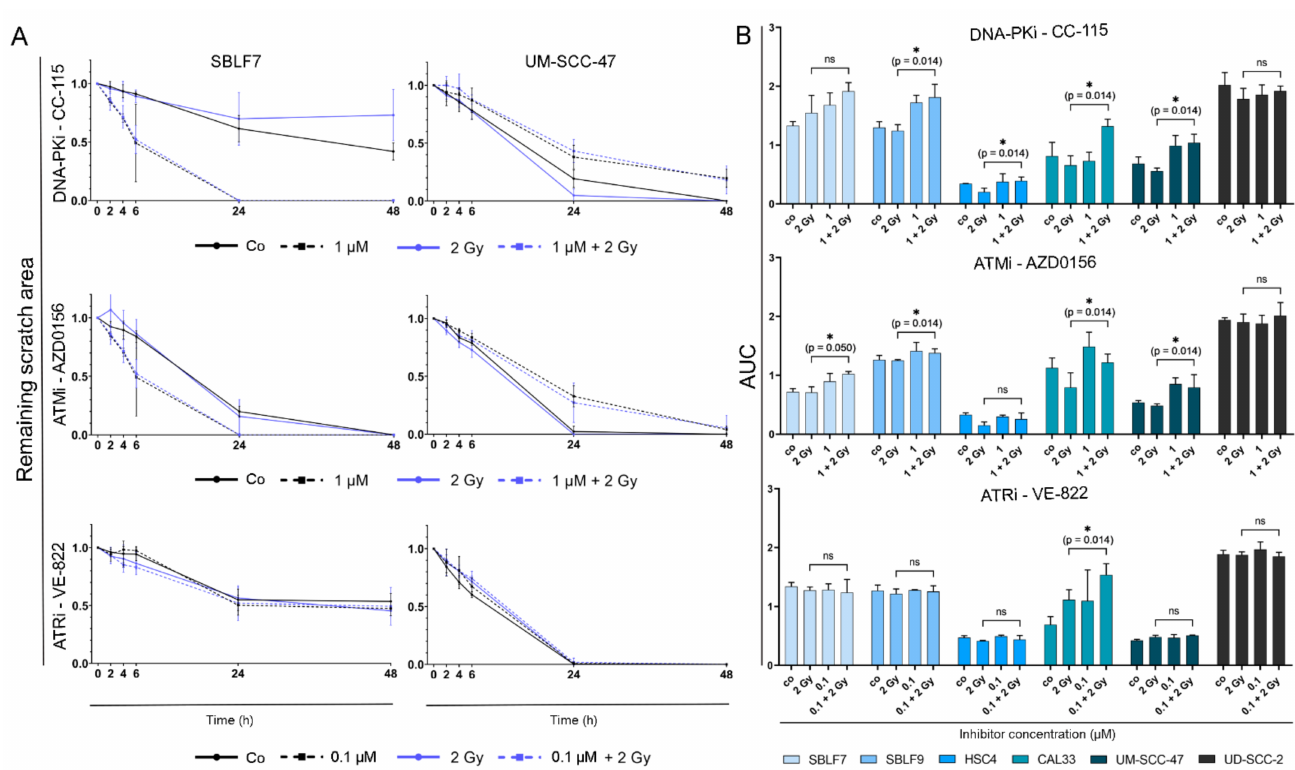
Figure 5. Analysis of cell migration over 24 and 48 h. ( A ) Change of scratch area over 48 h by the example of normal skin fibroblasts SBLF7 and HPV-positive HNSCC cell line UM SCC 47. Graphs show cells untreated, under IR, under KI (1 µ M CC 115, 1 µ M AZD0156, 0.1 µ M VE 822) and under combination therapy. ( B ) Area under the curve (AUC) was calculated representing cell migration over 48 h of four HNSCC cell lines and two normal fibroblast cell lines for all three tested KI. Each value represents mean ± SD ( n ≥ 3). Significance was determined by one tailed Mann Whitney U test * p ≤